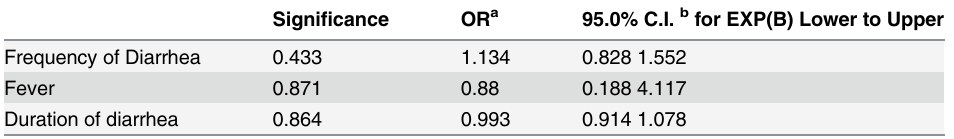
Table 3. Multiple-factor logistic regression analysis of the clinical symptoms of children with